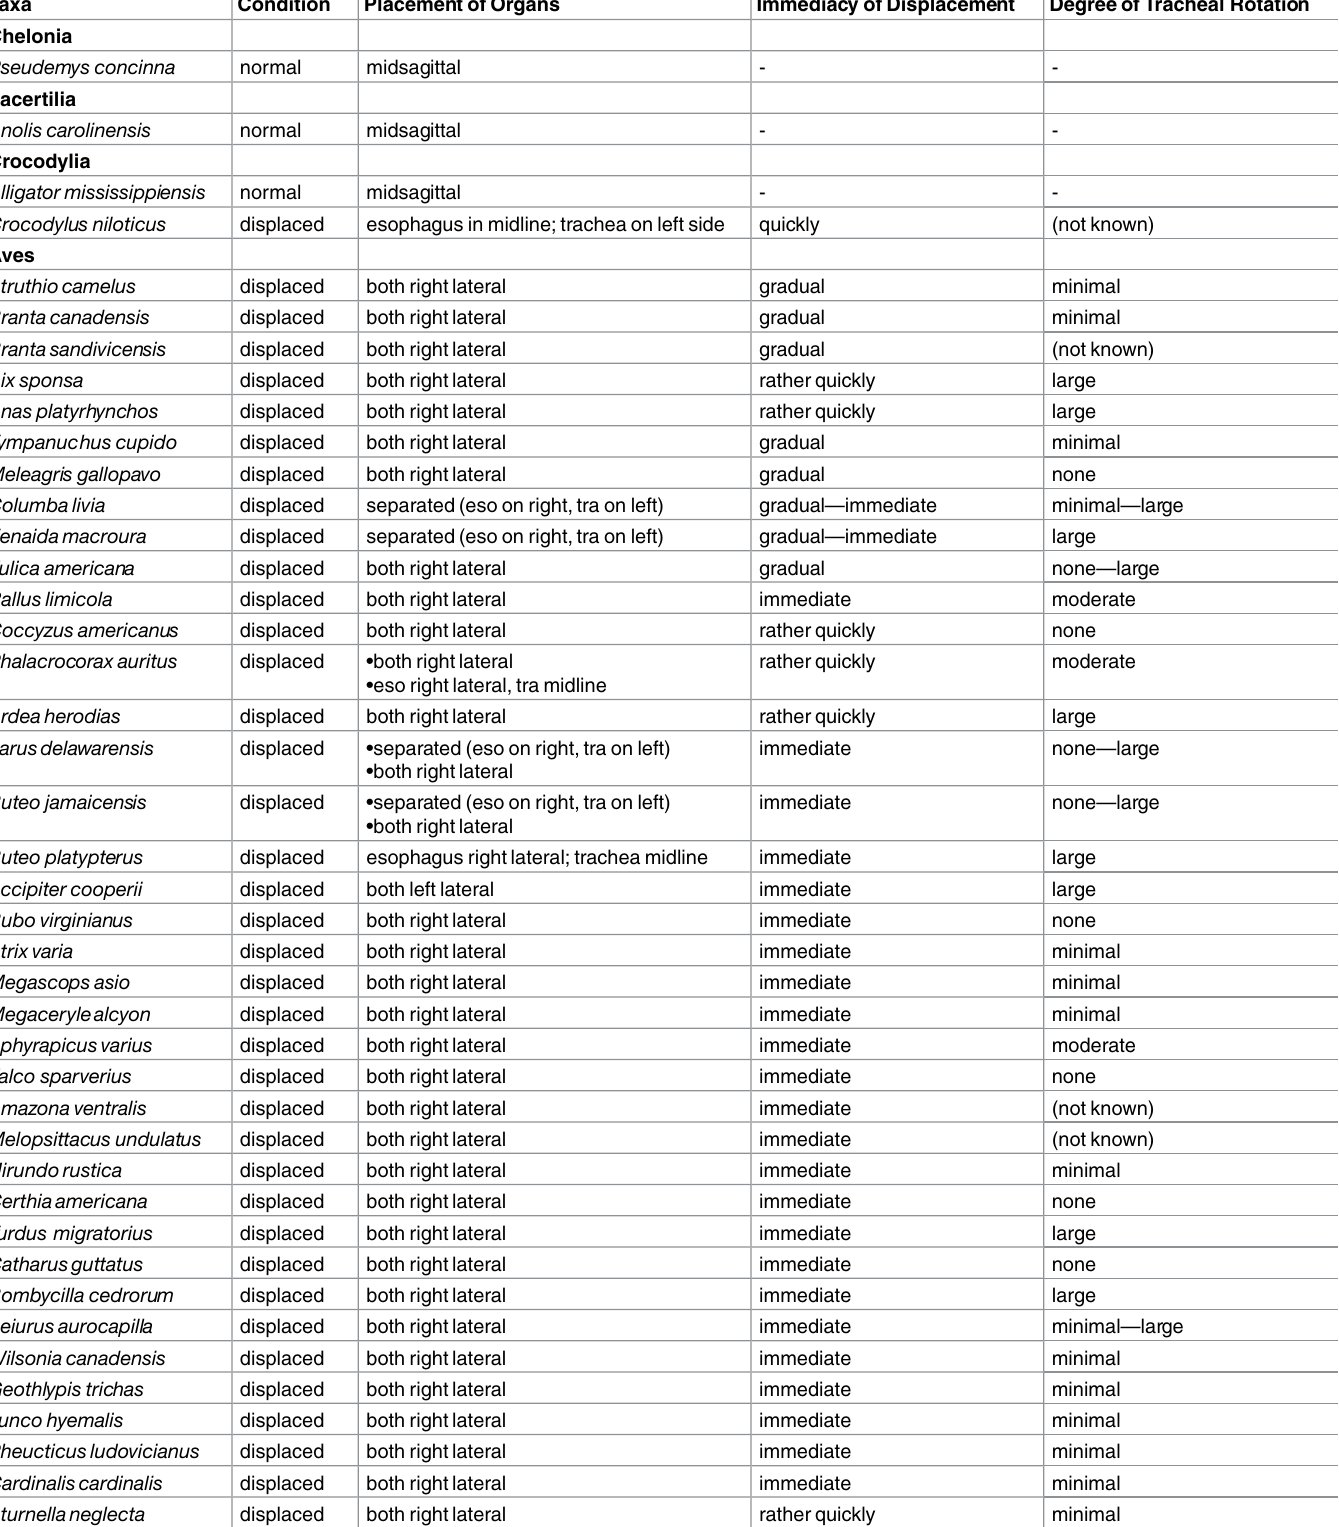
Table 2. Summaryof VertebrateTracheal and EsophagealPositions from Dissections and Personal Observations.